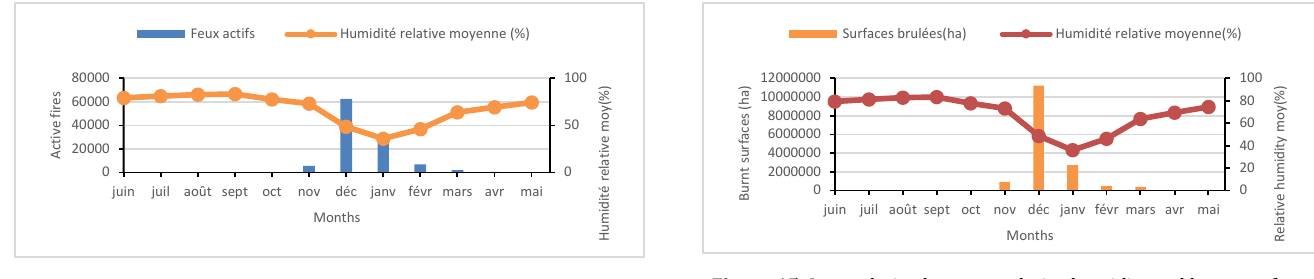
Figure 15: Interrelation between relative humidity and burnt surfaces Figure 12: Average relative humidity interrelation and number of active fires Table 2 presents the analysis of the correlation between active fires and